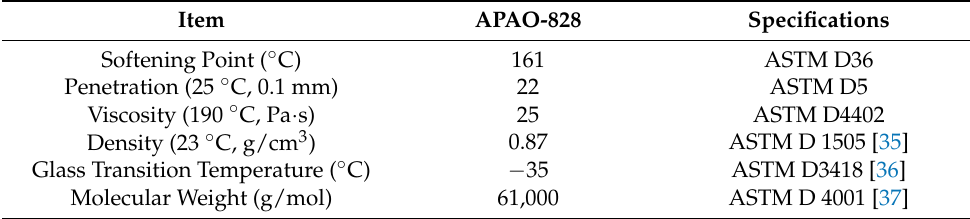
Table 3. Physical properties of